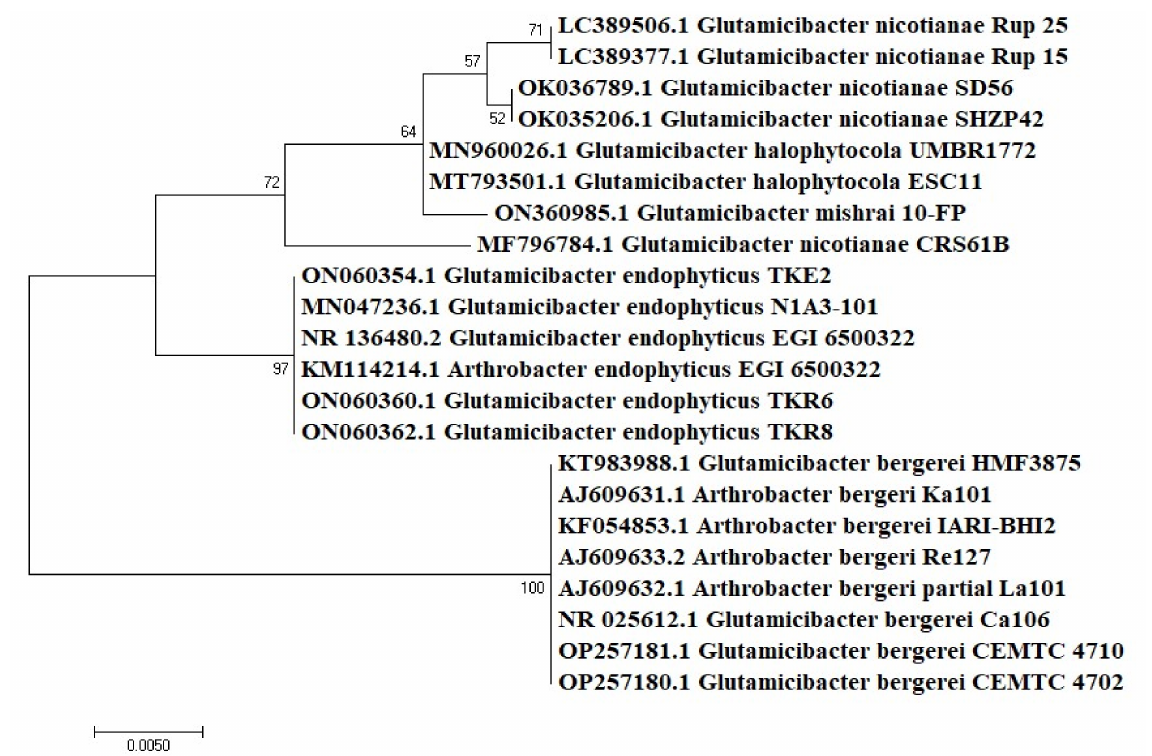
Figure 4. Phylogenetic tree reconstruction of Glutamicibacter species by maximum likelihood method using 1000 bootstrap